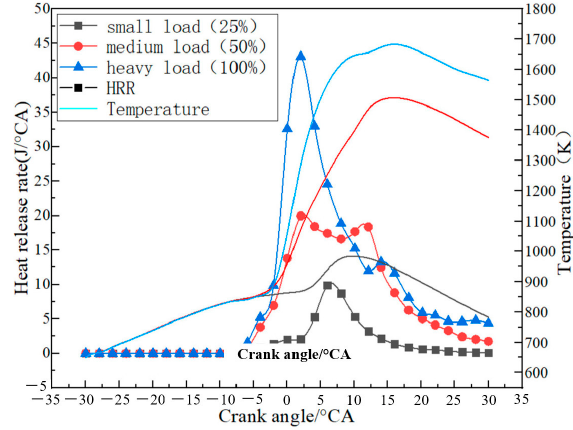
Figure 20. Variation of heat release rate with load.